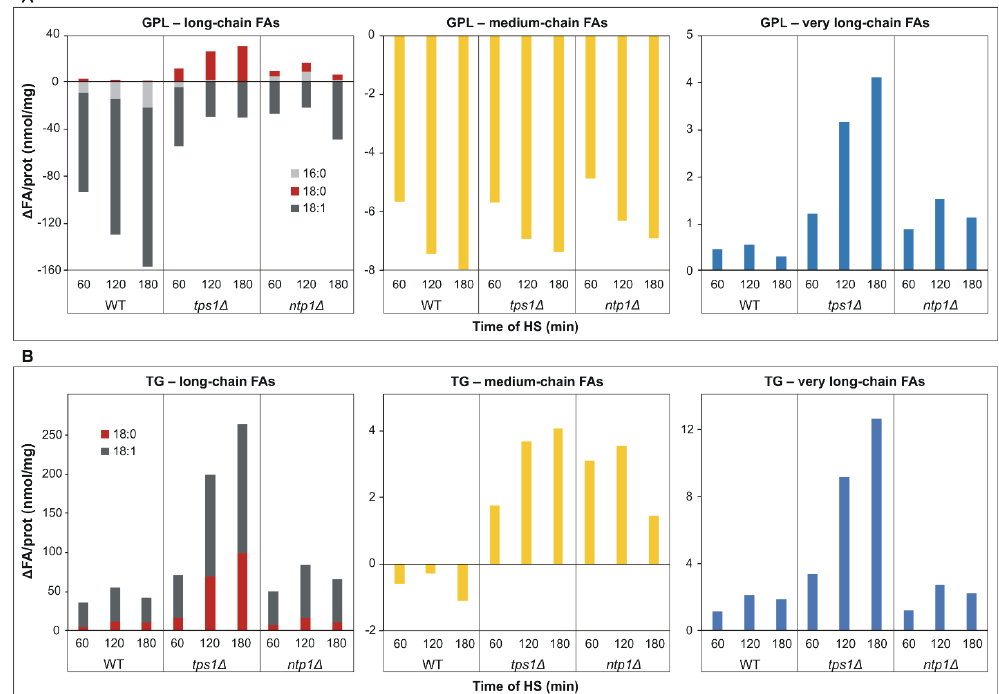
Figure 7. Net lipidome changes at the level of fatty acids (FAs) upon heat stress (HS). Yeast cells were heat-stressed at 40 °C for 0–180 min. Alterations in FA contents were calculated as Δ FA/prot (after HS − before HS) (nmol/mg) values for long-chain, medium-chain (C ≤ 12) and very long-chain (C ≥ 22) FAs ( A ) for GPLs and ( B ) for TG. Averages are shown from n = 3 independent experiments. Data were reconstituted based on MS/MS fragmentation results. WT, wild-type; tps1 ∆ , trehalose-deficient; ntp1 ∆ , trehalase-deficient S. pombe strains. FA, fatty acid; GPL, glycerophospholipid; TG,